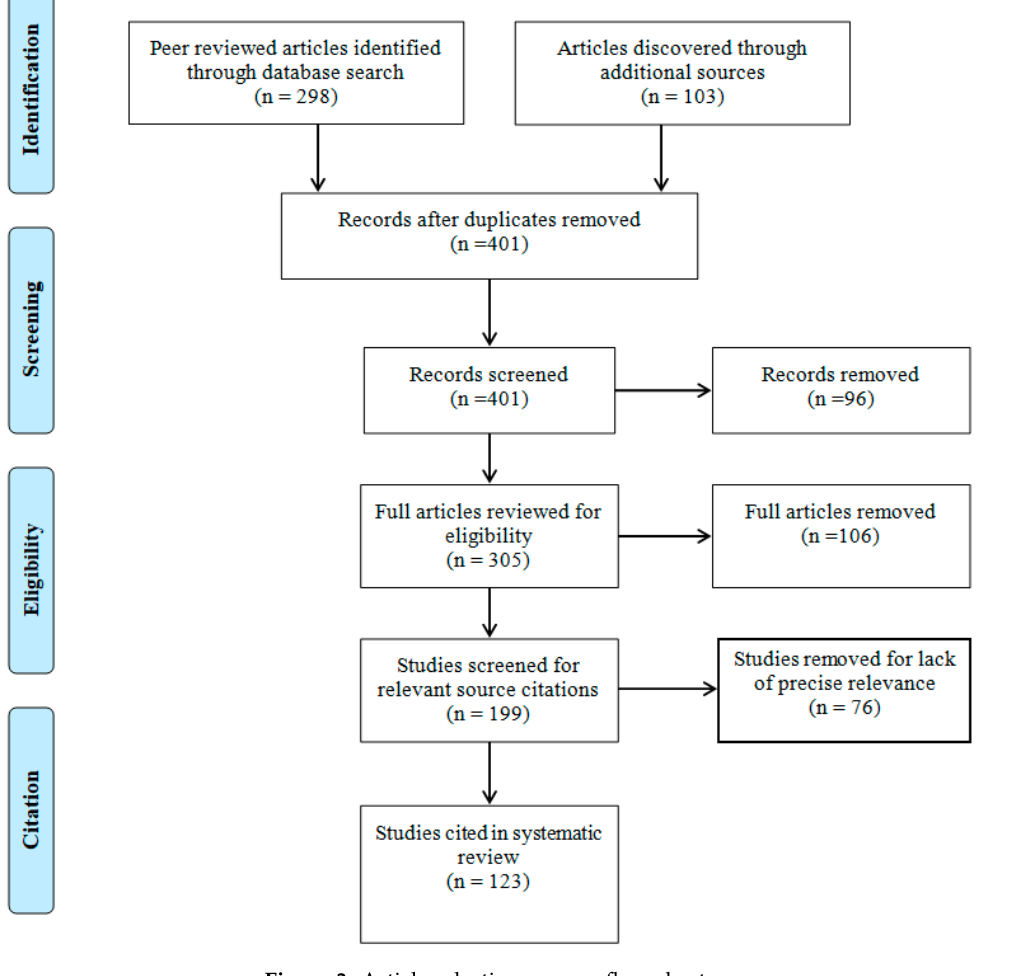
Figure 3. Article selection process flow chart.